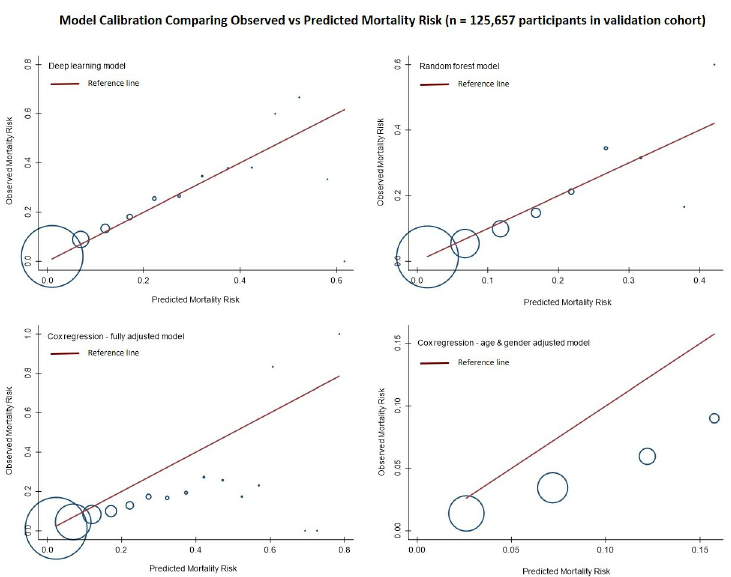
Fig 4. Calibration of algorithms for predicting all-cause mortality in the test cohort (n = 125,657). Red line indicates predicted risk of mortality plotted against observed proportion of mortality in blue circles across deciles of predicted risks.